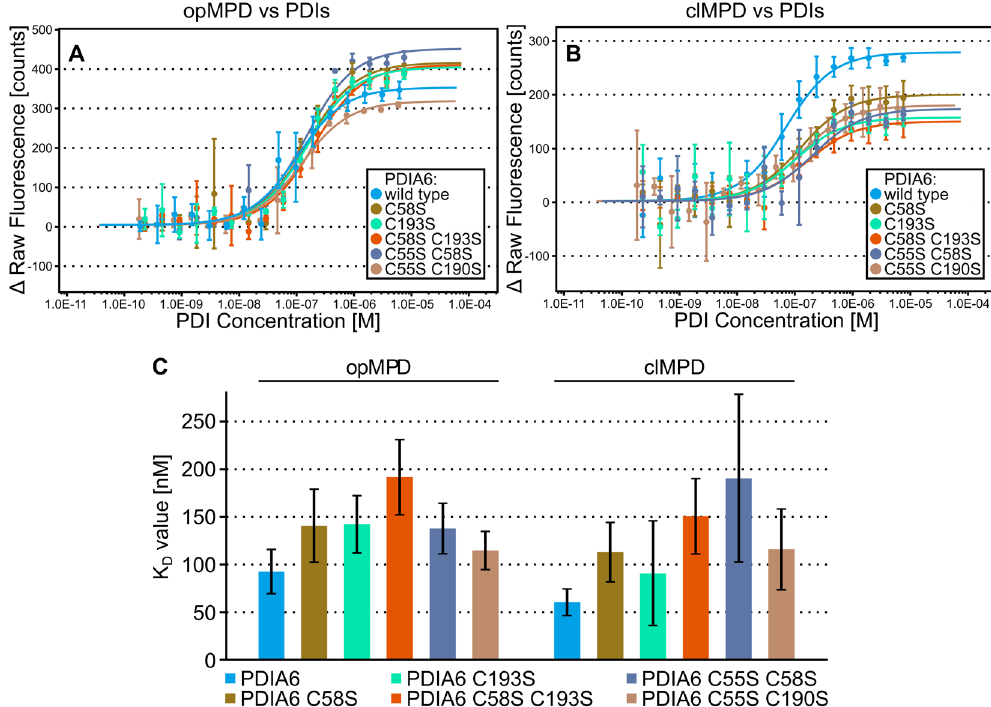
Figure 5. MST analysis (initial fluorescence, n = 3) of PDIA6 TRAP mutants with opMPD ( A ) or clMPD ( B ). Respective dose-response curves are indicated in the caption. ( C ) Corresponding K D values are summarized in a column chart (the error bars indicate respective 68% confidence